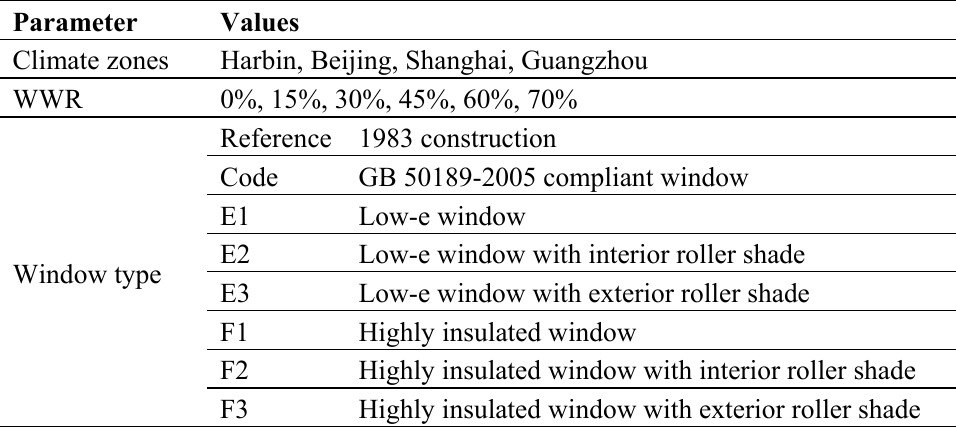
Table 4. EnergyPlus parametric